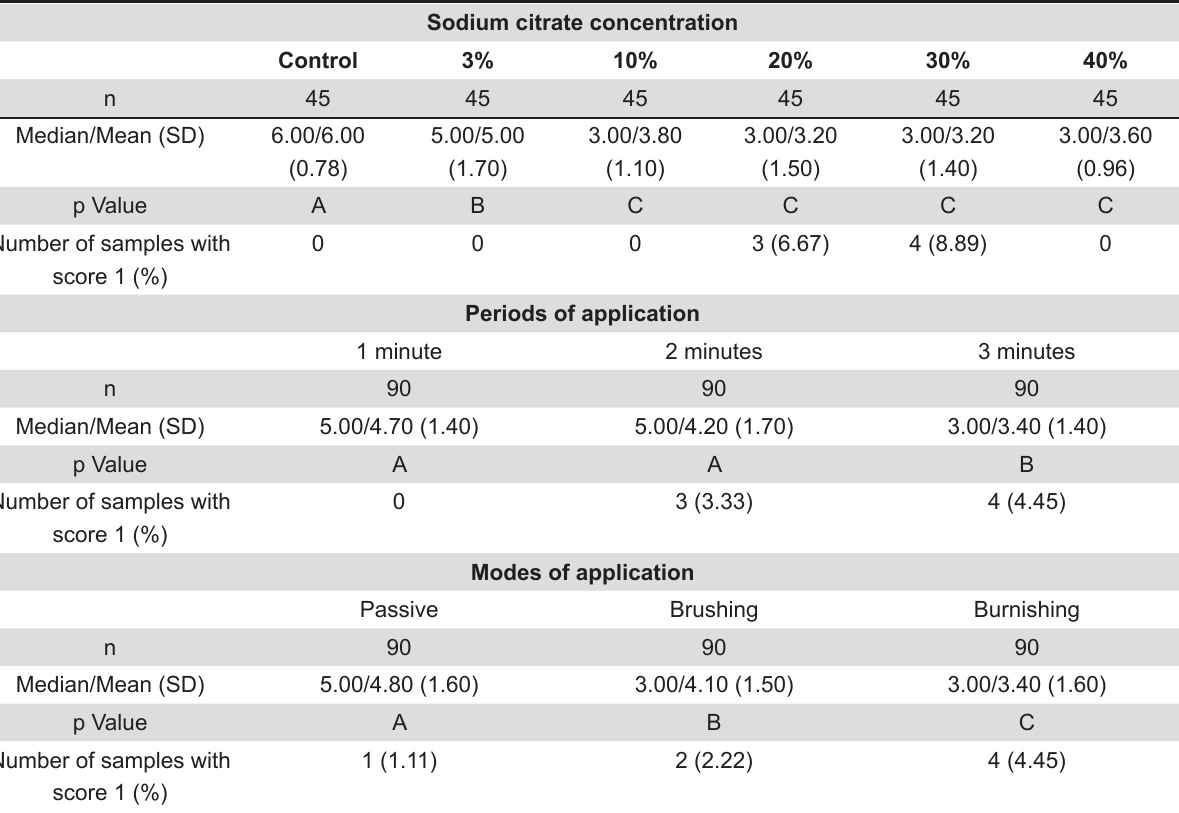
Table 2- Sample distribution for the sodium citrate concentrations, periods and modes of